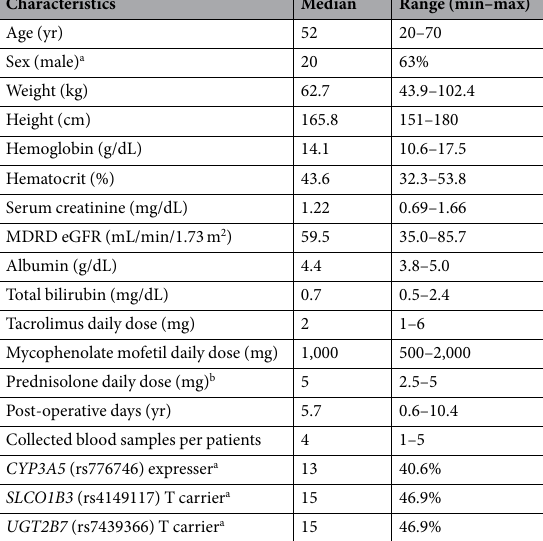
Table 1. Baseline characteristics of included patients ( n = 32). a Sex and CYP3A5 expresser are presented as number and proportion; b Prednisolone or its equivalent; CYP3A5 expresser, CYP3A5 * 1/ * 1 or CYP3A5 * 1/ * 3 carriers; MDRD, modification of diet in renal disease; eGFR, estimated glomerular filtration